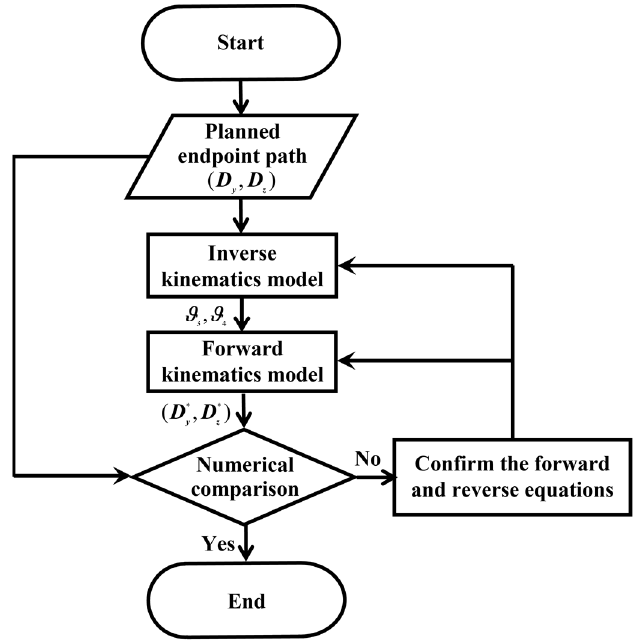
Figure 6. The verification process of forward and inverse kinematics.